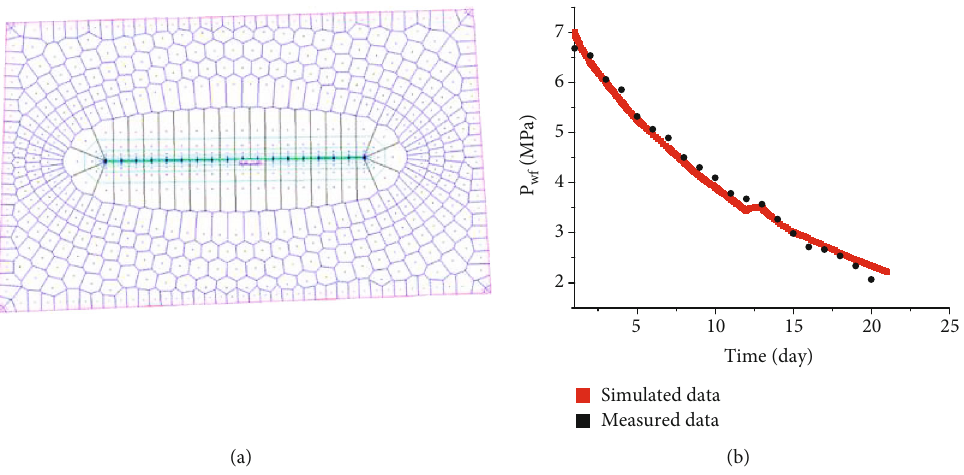
Figure 4: Pressure history of meshing and fi tting of the C1